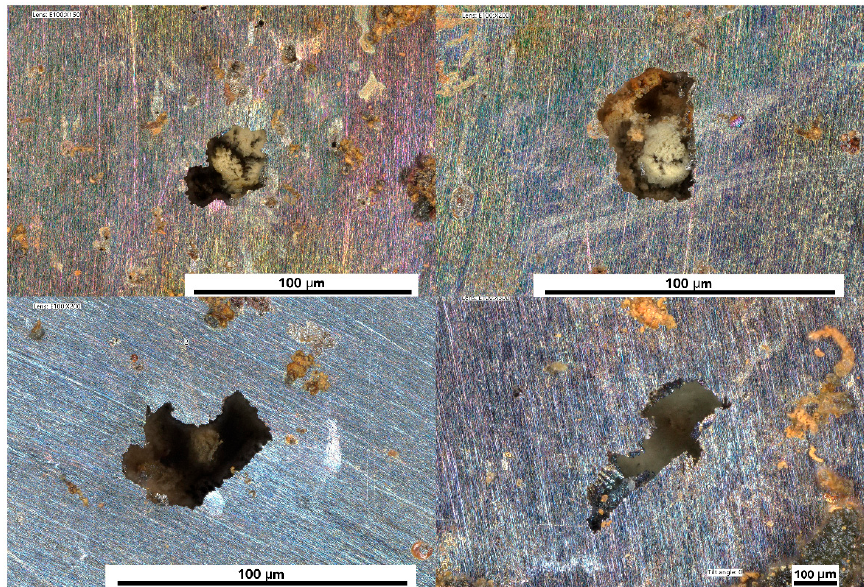
Coatings 2020 , 10 , x FOR PEER REVIEW Figure 12. The pitting locations sampled from the P1 and P2 areas. Figure 12. The pitting locations sampled from the P1 and P2 areas.